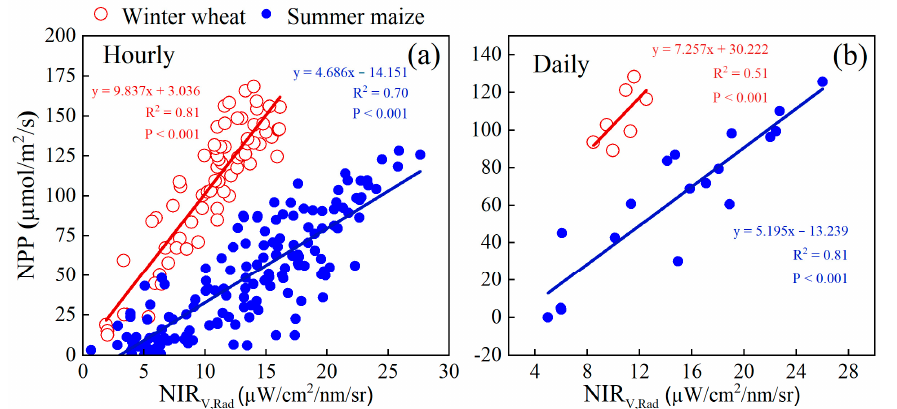
Figure 6. Scatterplot of NIR v,Rad –NPP relationships for winter wheat (C3) and summer maize (C4) on hourly and daily scales. p < 0.001 on both hourly and daily scales. The red and blue lines represent the fitting curve between the near-infrared radiance index and NPP of winter wheat and summer maize, respectively.